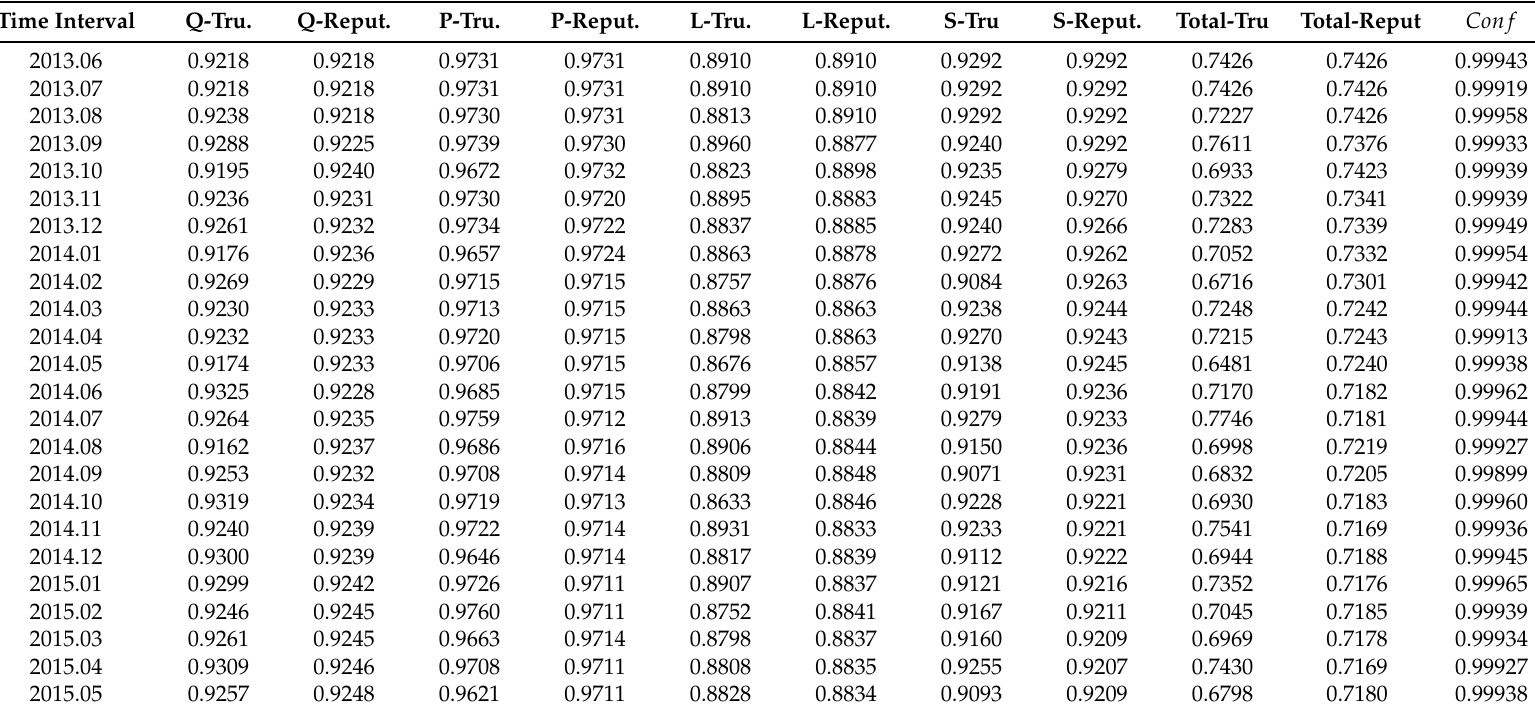
Table 6. Computational results of reputation and trust for books on Dangdang over 24